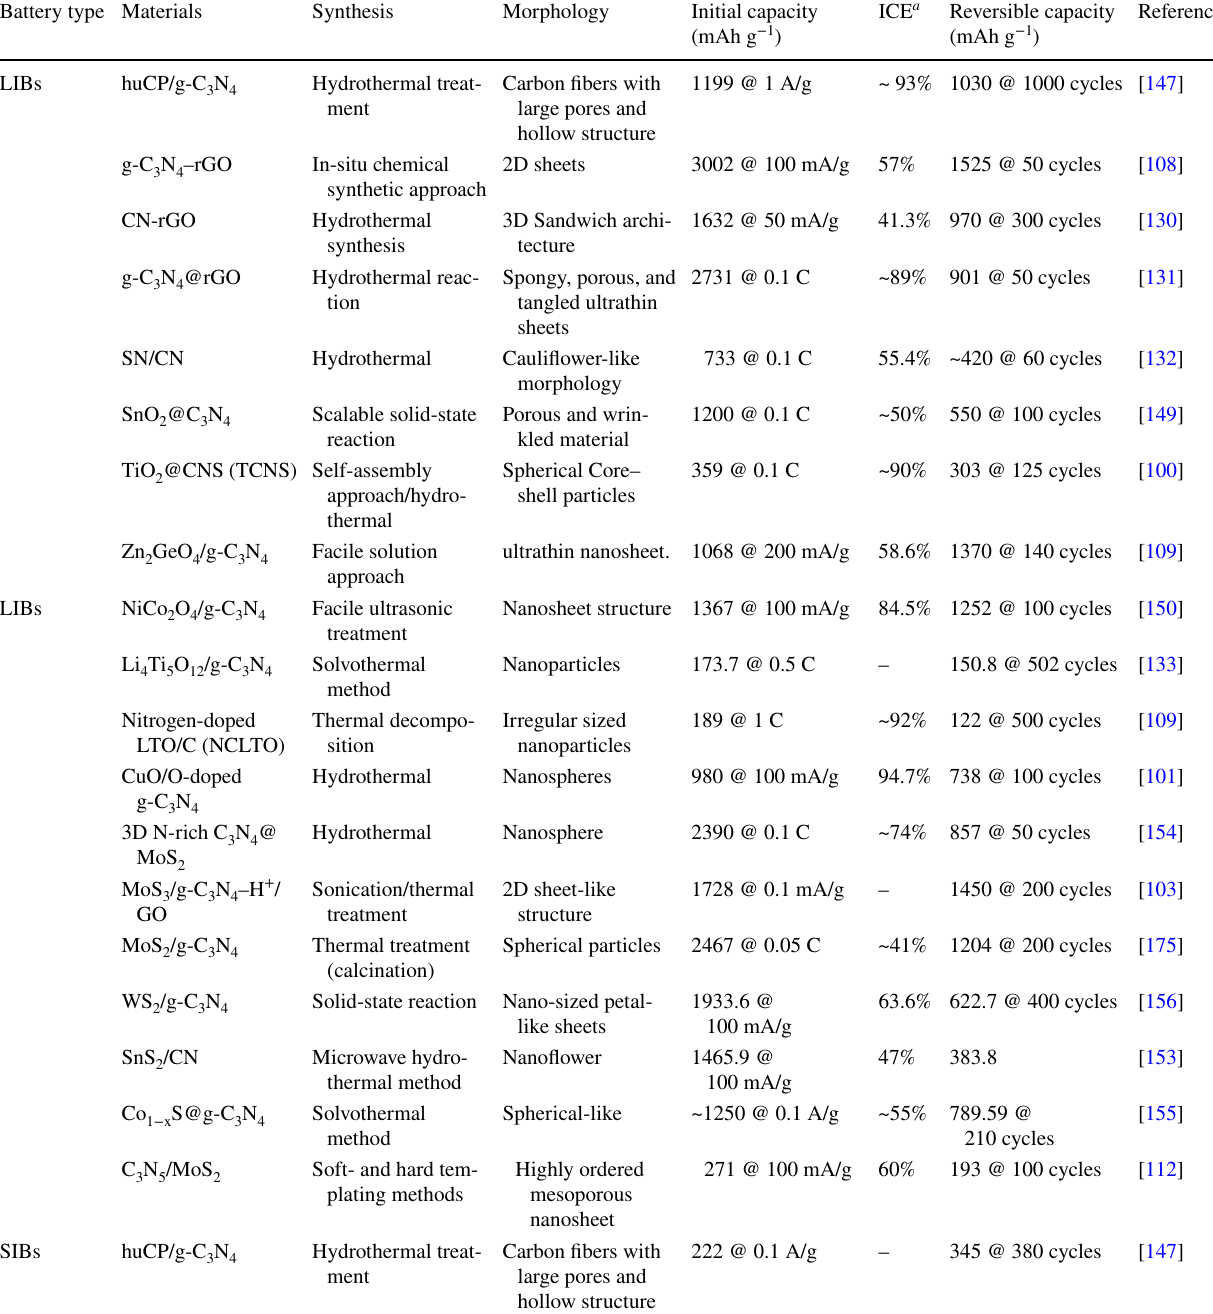
Table 3 CNBCs for metal-ion batteries LIBs, SIBs and PIBs Battery type